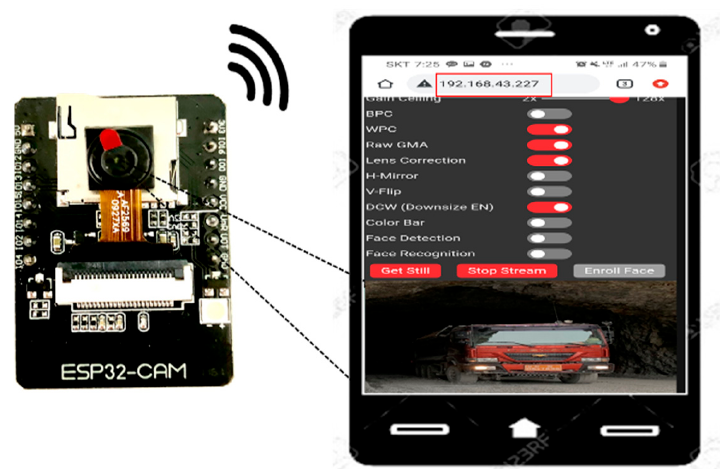
Figure 2. Operation process of the ESP32-CAM.